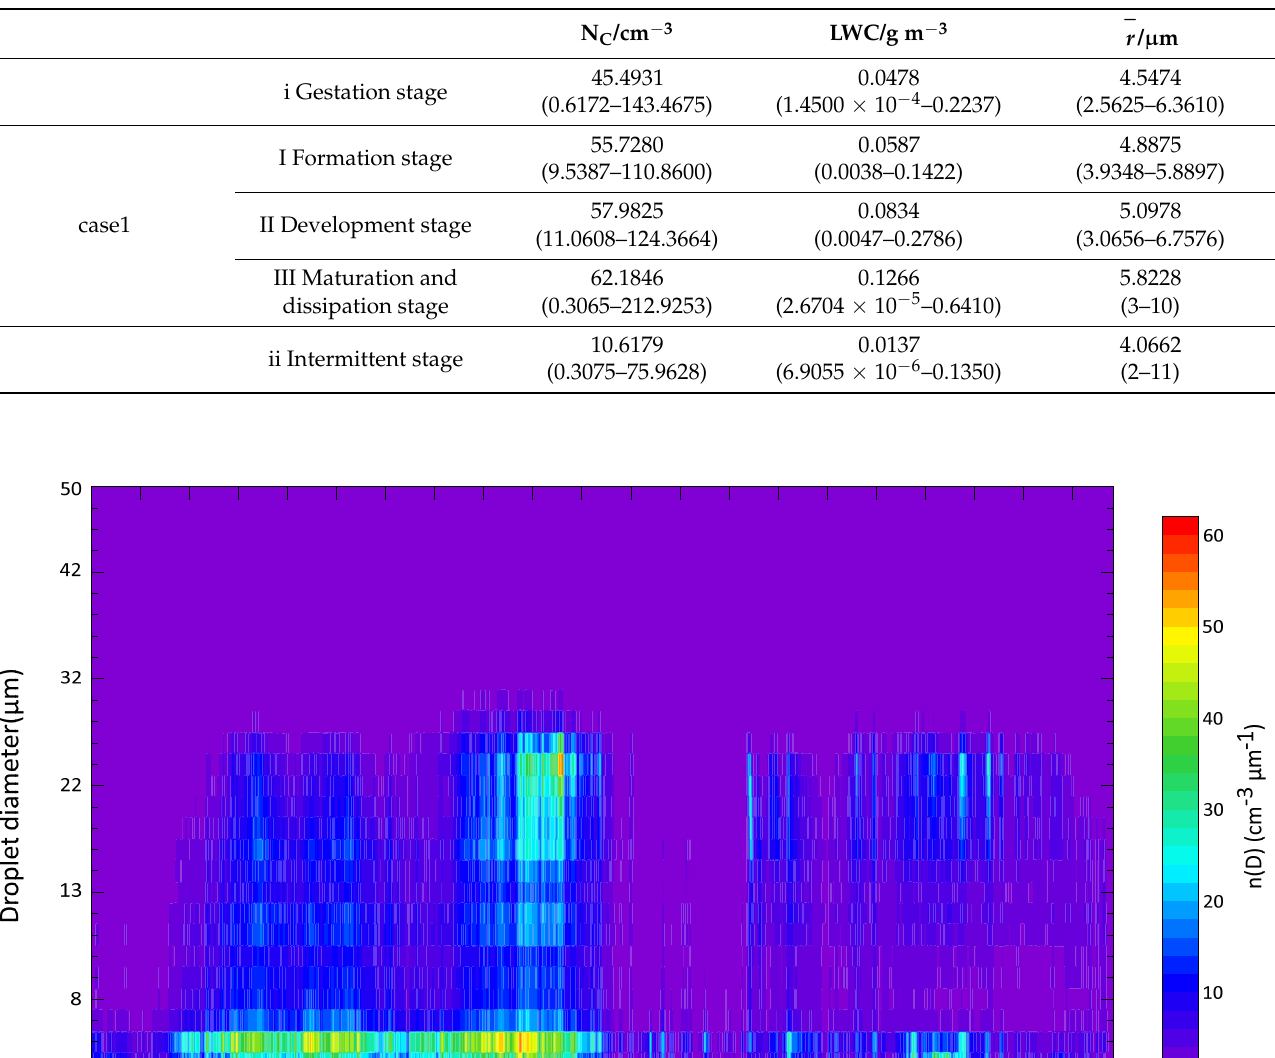
Table 4. Average, maximum, and minimum values of key characteristic parameters of case1 process, gestation stage, and intermittent stage.